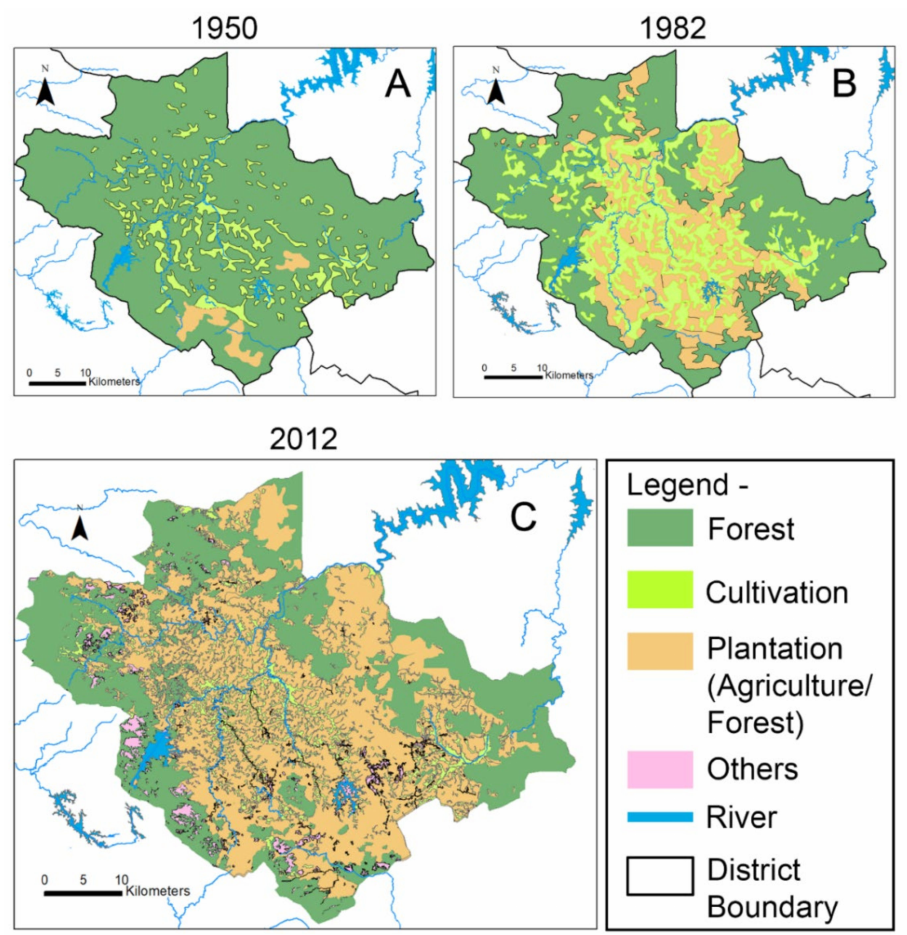
Figure 2. Land use land cover change of Wayanad district from 1950 to 2012; ( A ) land use land cover till 1950; ( B ) land use land cover till 1982; and ( C ) land use land cover till